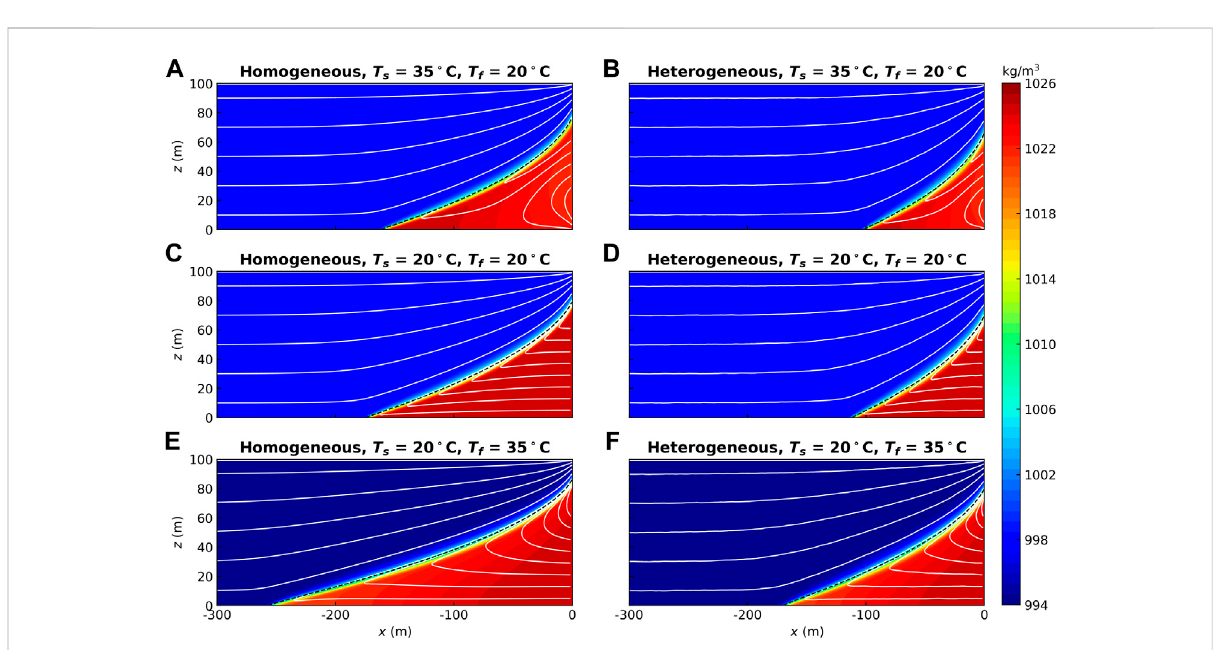
FIGURE 4 Density distributions in coastal aquifers subjected to different FW-SW temperature contrasts. The left-hand (A, C, E) and right-hand (B, D, F) panels are the results for homogeneous and heterogeneous aquifers, respectively. The results for heterogeneous aquifers ( σ 2 ln k = 1 and λ x = 0.5 m) are averaged ( n = 50). The black dashed lines are the 50% seawater concentration isohalines (17.5 ppt), i.e., the FSI. Note that only the sections from x = − 300 to 0 m are presented. The white lines show fl ow streamlines. T s and T f are seawater and freshwater temperatures,